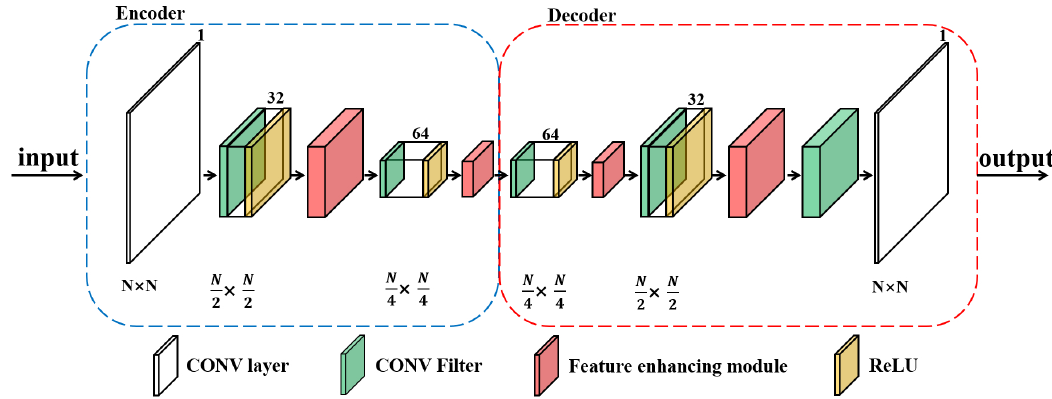
Figure 5. The neural structure of the generator in the pixel regression